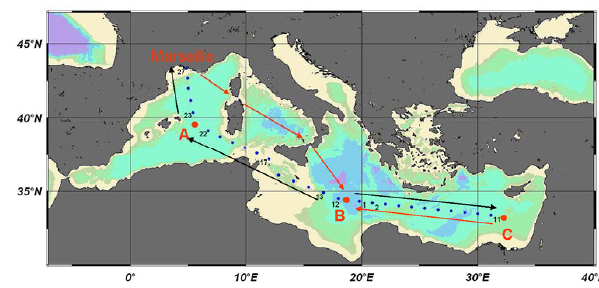
Figure 1. Fig. 1. Transect performed during the BOUM cruise (16 June–20 July 2008). Short duration (SD) stations are reported as blue dots while long duration (LD) stations sampled in the centre of anticy- clonic eddies for a time period of 3 days are reported as red dots (namely stations A, B and